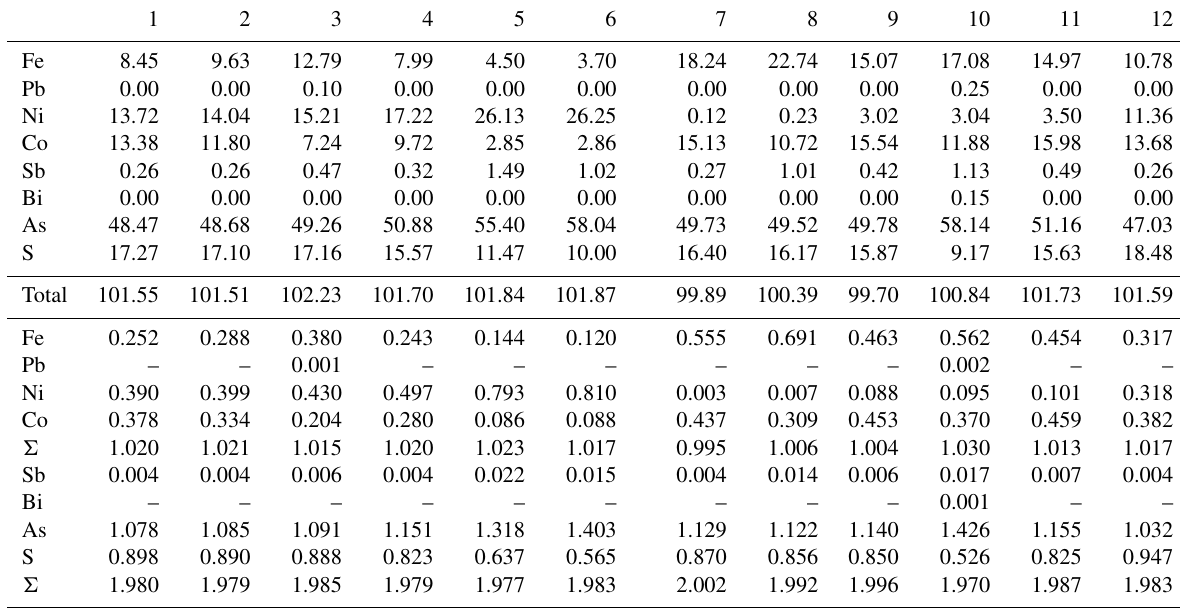
Table 9. Representative analyses (wt%) for Ni–Fe–Co sulfarsenides from Pˇríbram.